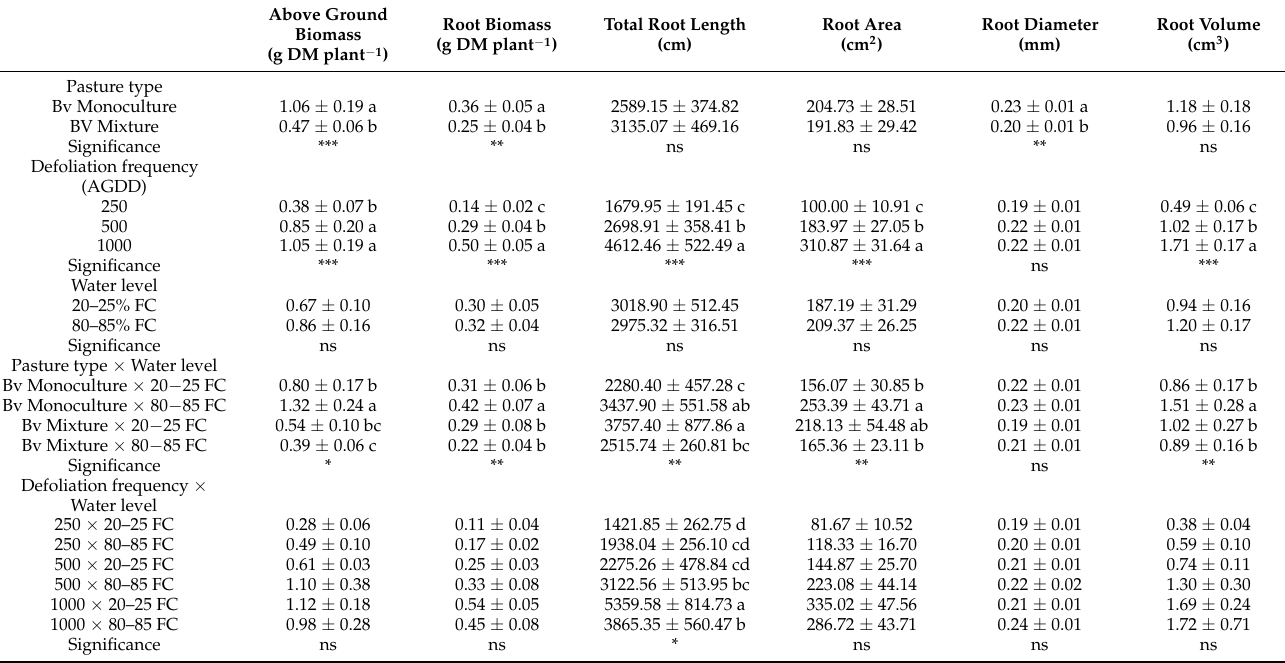
Letters that differ within columns indicate values that are significantly different at the following levels: * p ≤ 0.05; ** p ≤ 0.01; *** p ≤ 0.001; ns, not significant ( p >